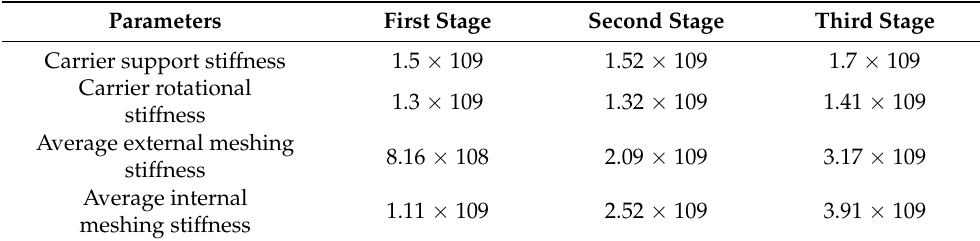
Table 3. Stiffnesses for all stages